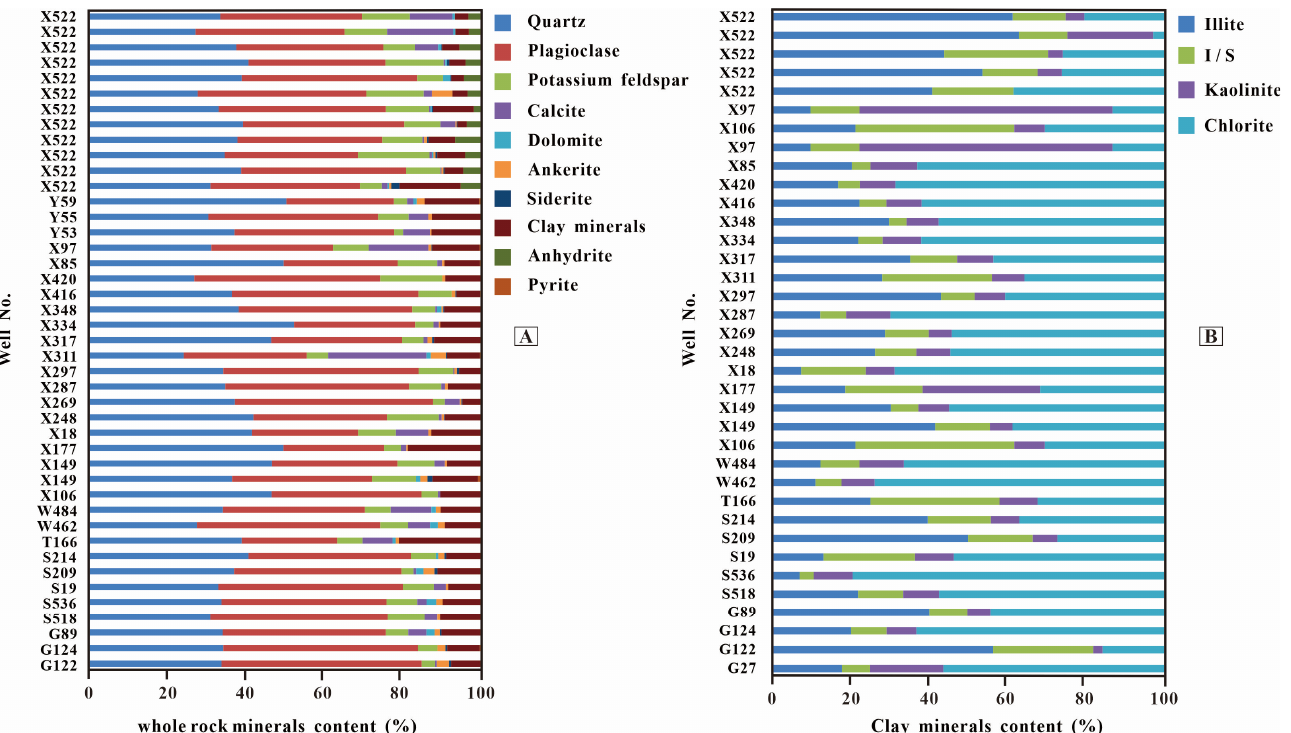
Figure 4. Relative percentage of minerals of Chang 8 Member in the Yanchang Formation tight sand- stone reservoirs in study area. ( A ) Characteristics of mineral composition of whole rock. ( B ) Char- acteristics of mineral composition of clay minerals.